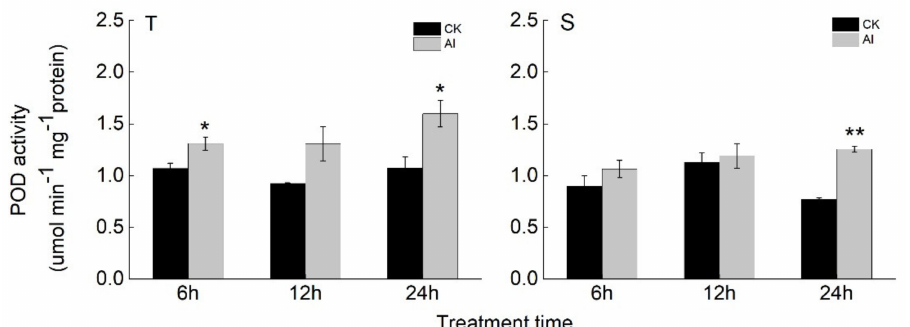
Figure 4. POD activity in the roots of two soybean varieties, T and S. The 17-d-old seedlings were exposed to control (CK) or Al stress (25 µ M AlCl 3 ) for 6, 12, and 24 h. Means and standard errors were calculated from three biological replications, with 12 plants per replication. * and ** indicate significant difference (student’s t -test) in POD activity between CK and Al stress for each time point at significance levels of 0.05 and 0.01,